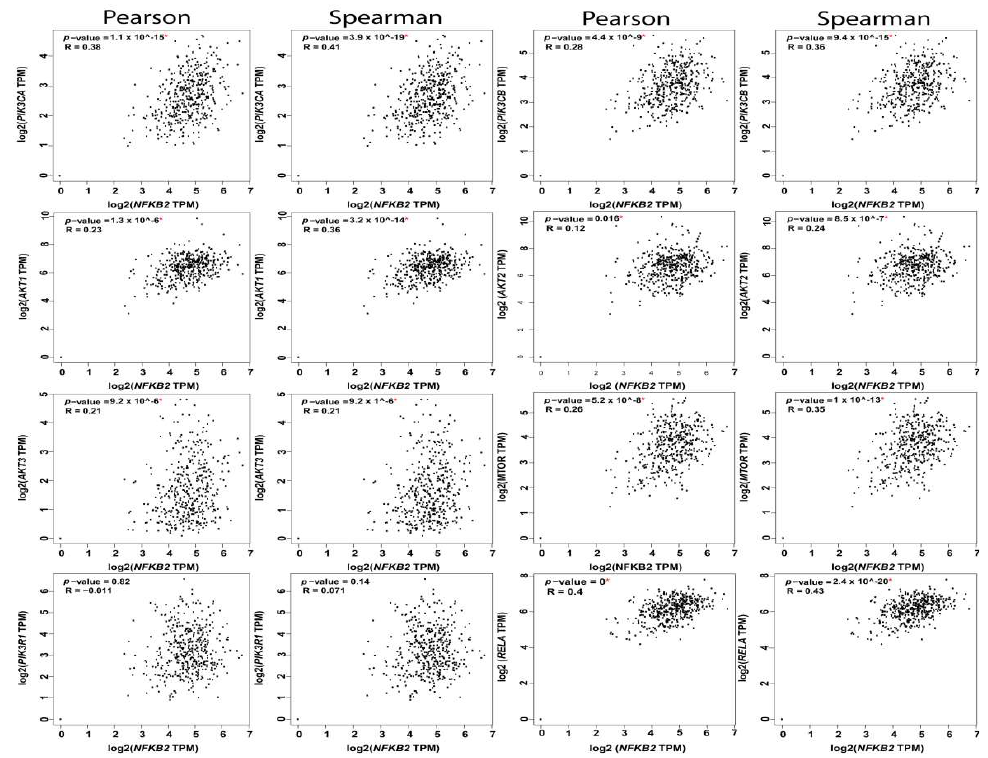
Figure 6. Correlation between NFkB2 subunit and the nodes of PI3K-AKT-mTOR and NFkB